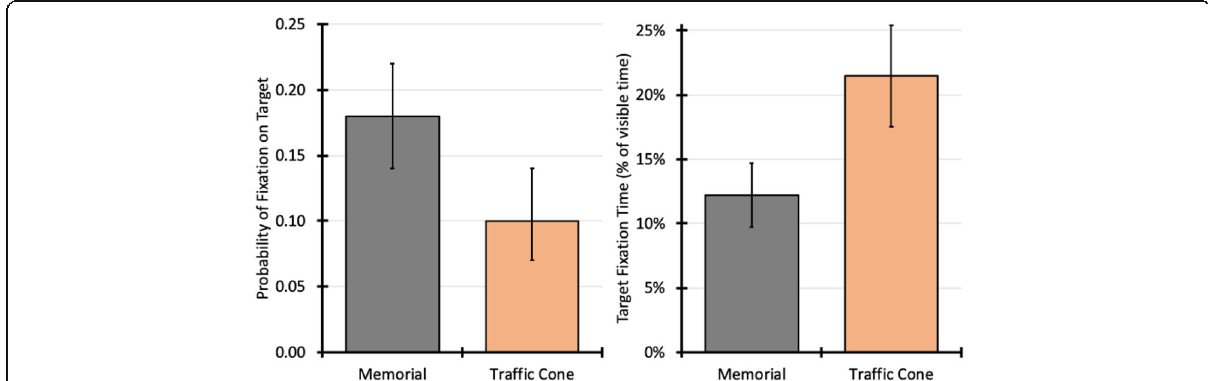
Fig. 2 Probability of fixating on the roadside target object (memorial or traffic cone; left panel) and total fixation time (right panel) as a percentage of visible time. Error bars represent 95% confidence